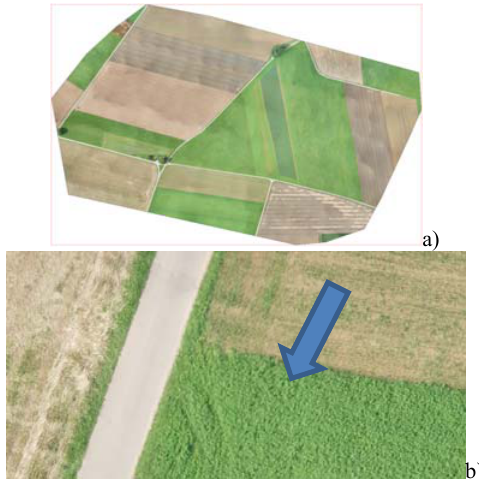
Figure 15: a) RGB-Orthomosaic in the test area Welzheim, b) patch with field of red clover (arrow) (Source: Flight and AT GerMAP GmbH, Orthomosaic Pieneering